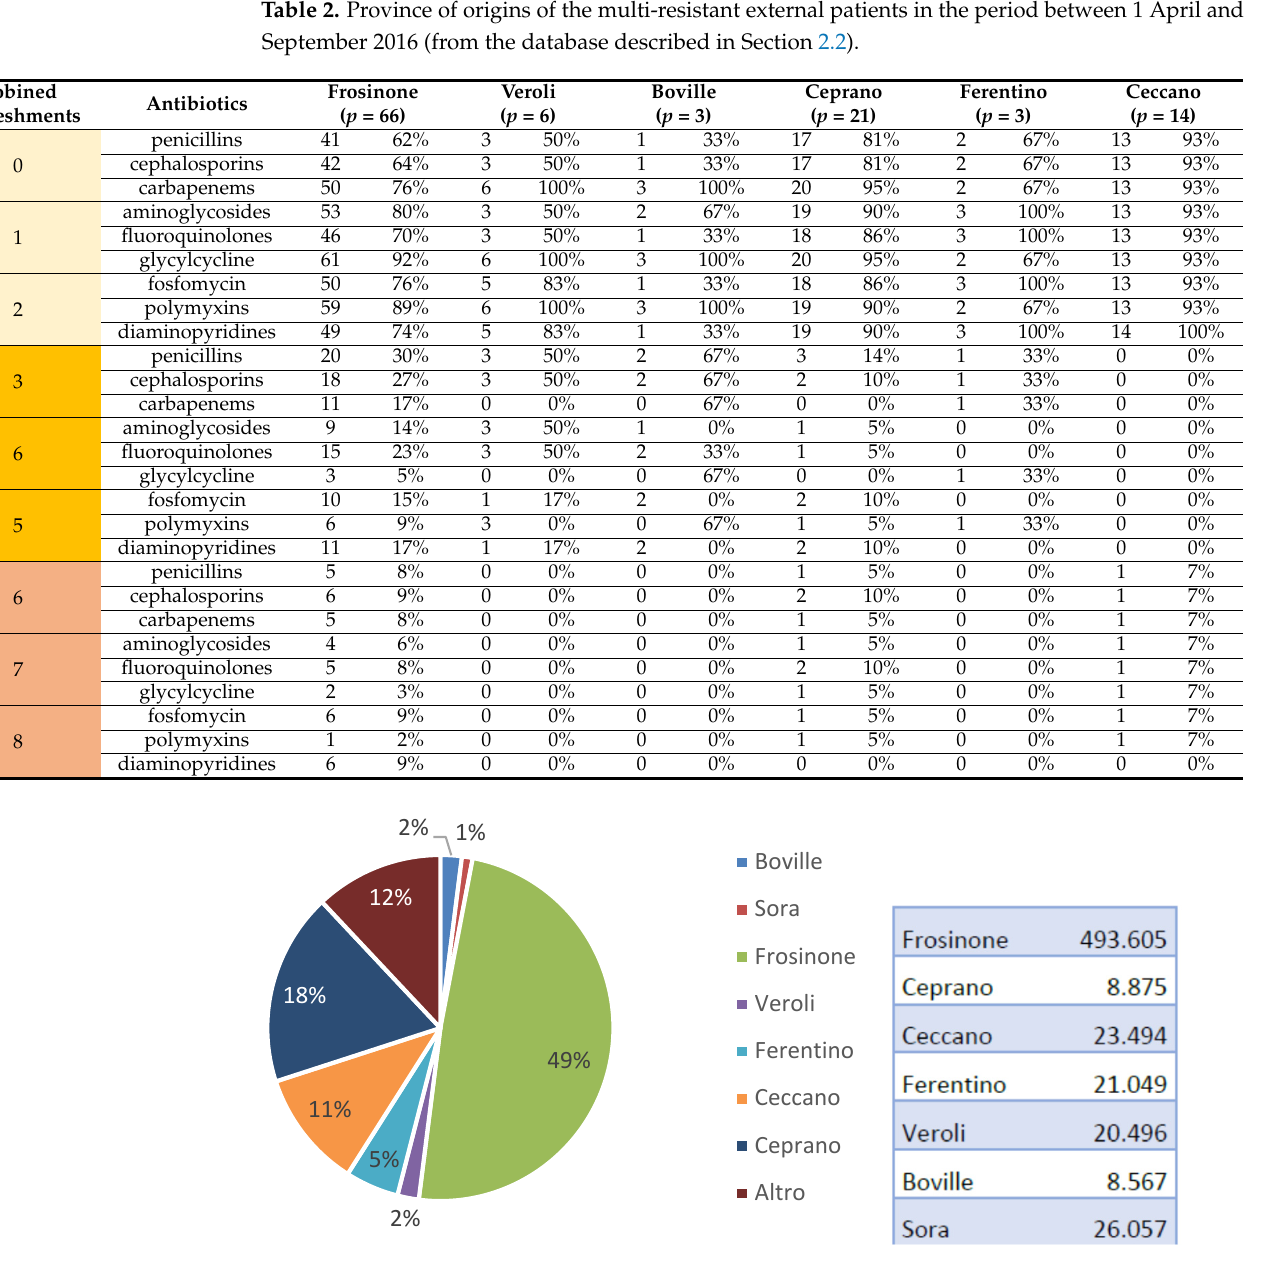
Figure 4. Left: Distribution of the patients’ provenance in percentage of the 494 external patients. Right: 2017 population of the various provinces as provided by the Italian National Institute of Statistics. Data were sourced from the database described in Section 2.2.